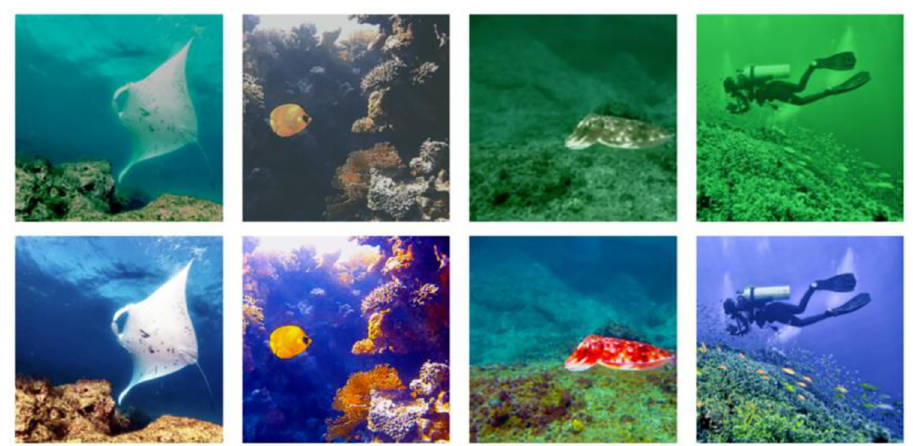
Fig 4. Comparison of underwater image enhancement effect. The upper line shows the original underwater images, and the lower line shows the enhanced images.